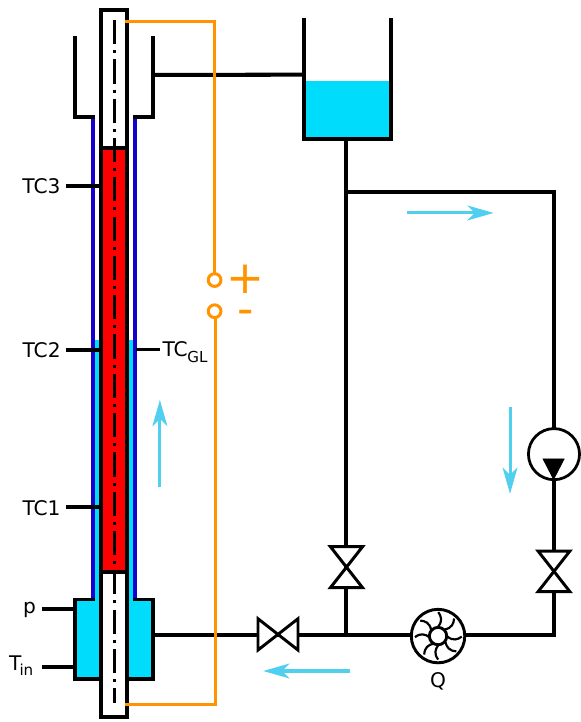
Figure 1. Simplified experimental loop